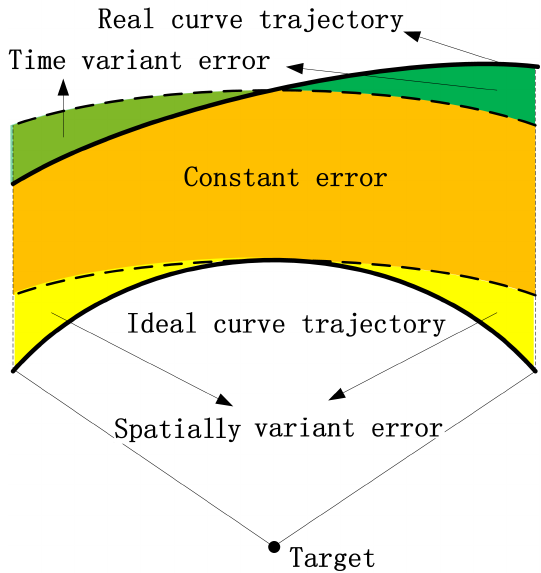
Figure 2. Division of the BTD